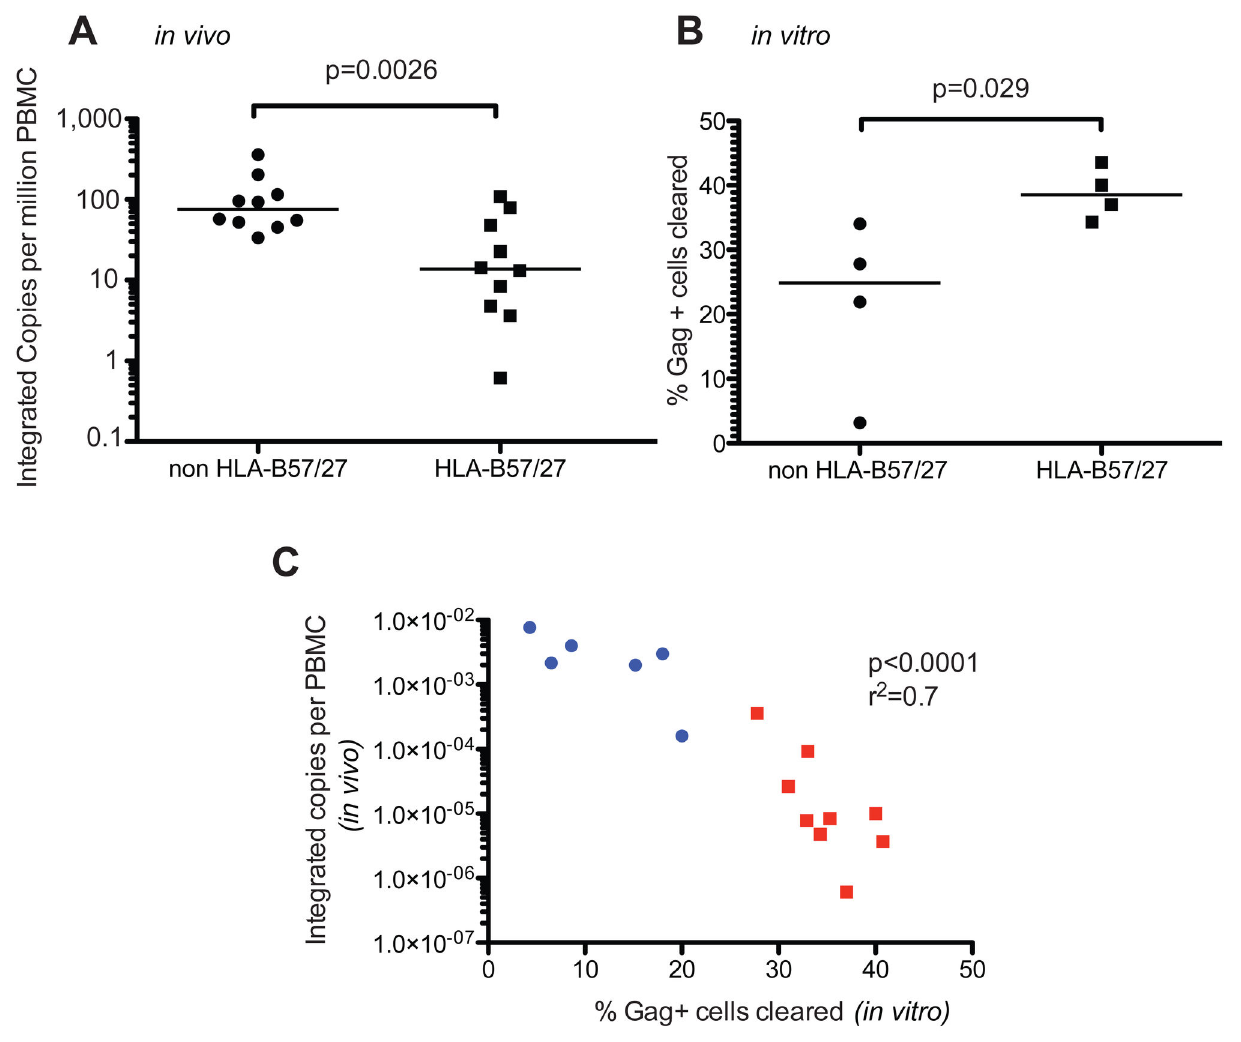
Figure 5. CTL clearance of GPR cells correlates with reservoir size in vivo . (A) Integrated copies per PBMC are plotted for EC with either B57 or B27 or EC without either allele. The line represents the median and the p value was calculated by a Mann- Whitney